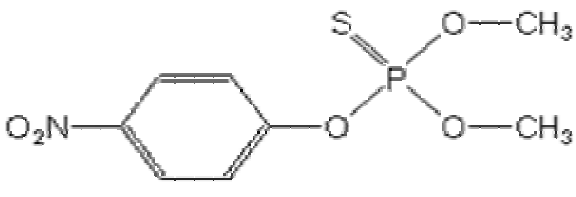
Figure 1: Structure of methyl parathion The physiochemical characteristics of methyl parathion are presented in Table 1 [16-18]. Table 1: Physiochemical characteristics of methyl parathion